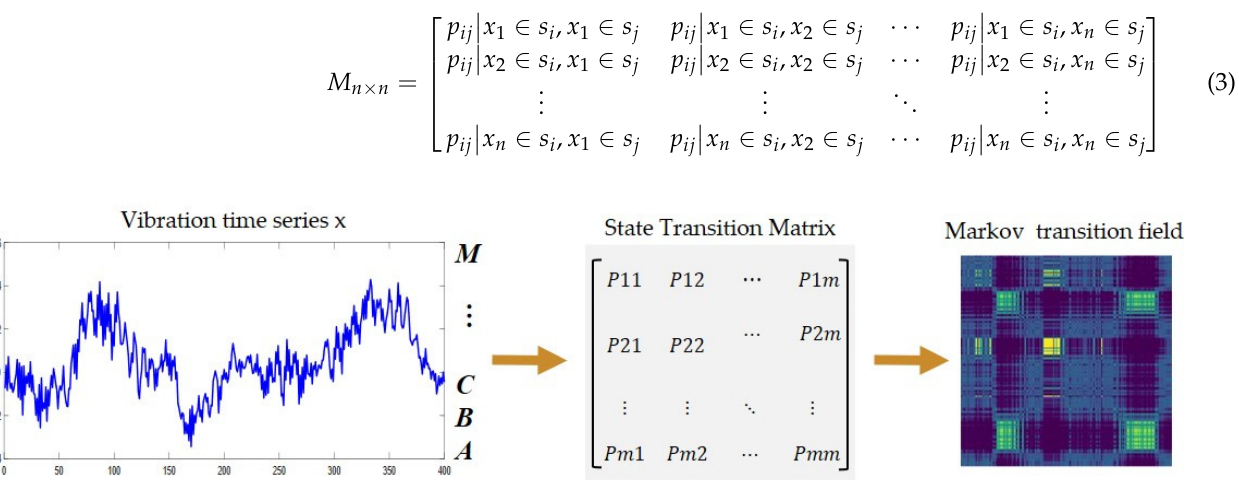
Figure 1. Timeseries feature representation by MTF.